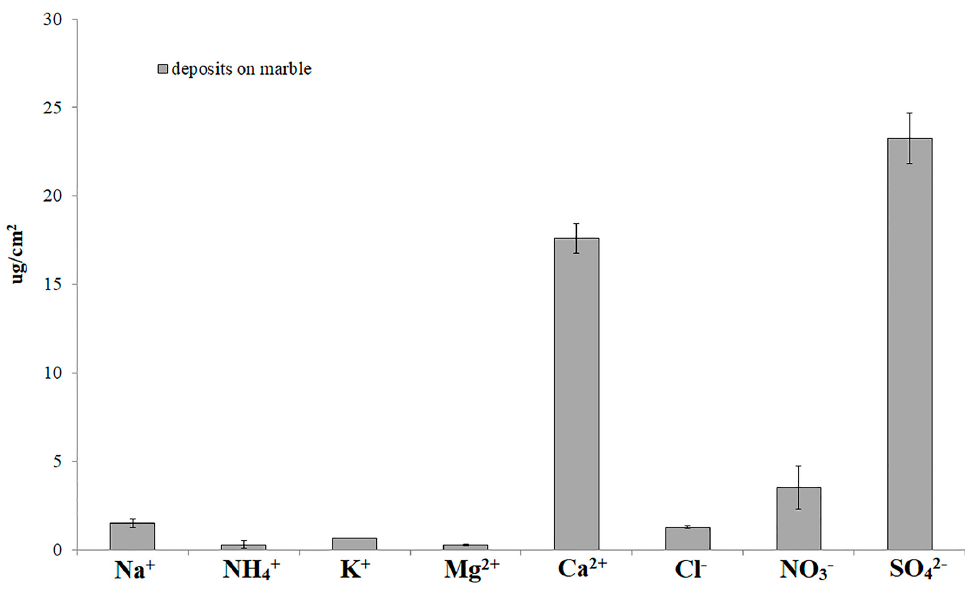
Figure 8. Cations and anions average concentrations determined in the deposits on marble specimens exposed on the Duomo façade during the first period (2014–2015).